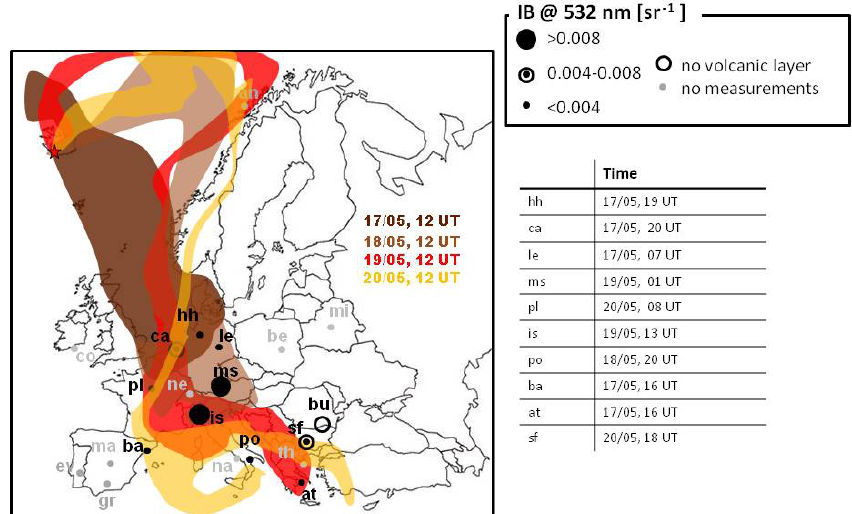
Fig. 13. Map of Europe showing the dispersion of the Eyjafjallaj¨okull (red star) volcanic aerosol plume during the 6–10 May 2010 period. The approximate location of the plume in the 3–5km height range is given for 12:00 UT on 17 May (dark brown), 18 May (light brown), 19 May (red), and 20 May 2010 (yellow). The maximum integrated backscatter (IB) at 532nm measured by each station is reported in black. The exact time location of the maximum IB reported is reported in the